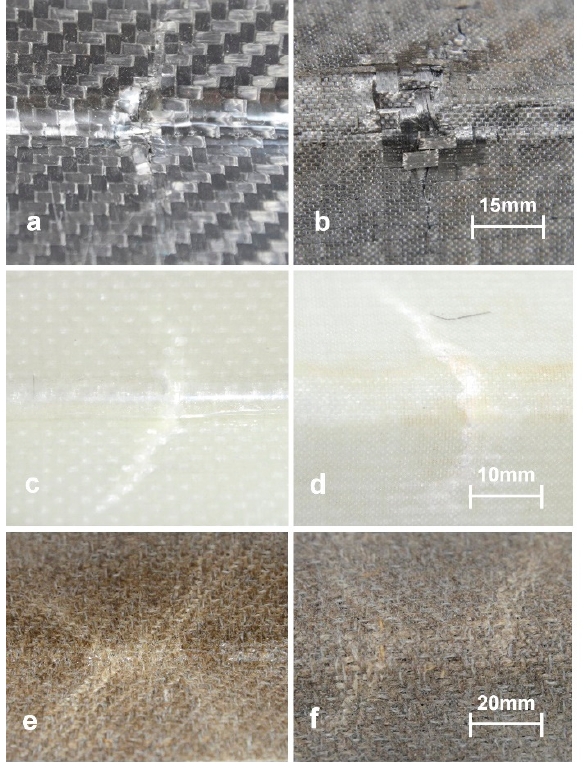
Figure 8. Exemplar matrix failures in the corners of the composite channels associated with the ultimate limit state: ( a ) carbon (inside view), ( b ) carbon (outside view), ( c ) glass (inside view), ( d ) glass (outside view), ( e ) flax (inside view) and ( f ) flax (outside view).